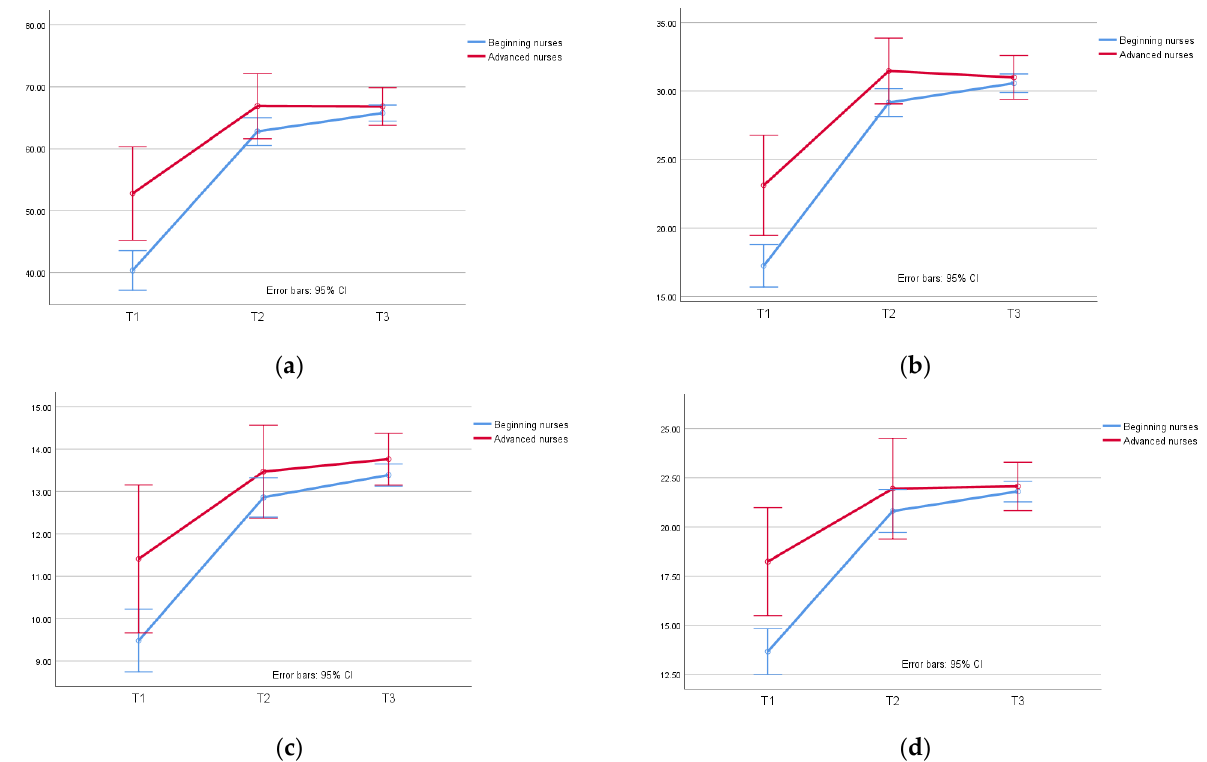
Figure 1. The results of PADIS scores for novice and advanced nurses: ( a ) PADIS scores; ( b ) knowledge scores; ( c ) attitude scores; ( d ) skills scores.